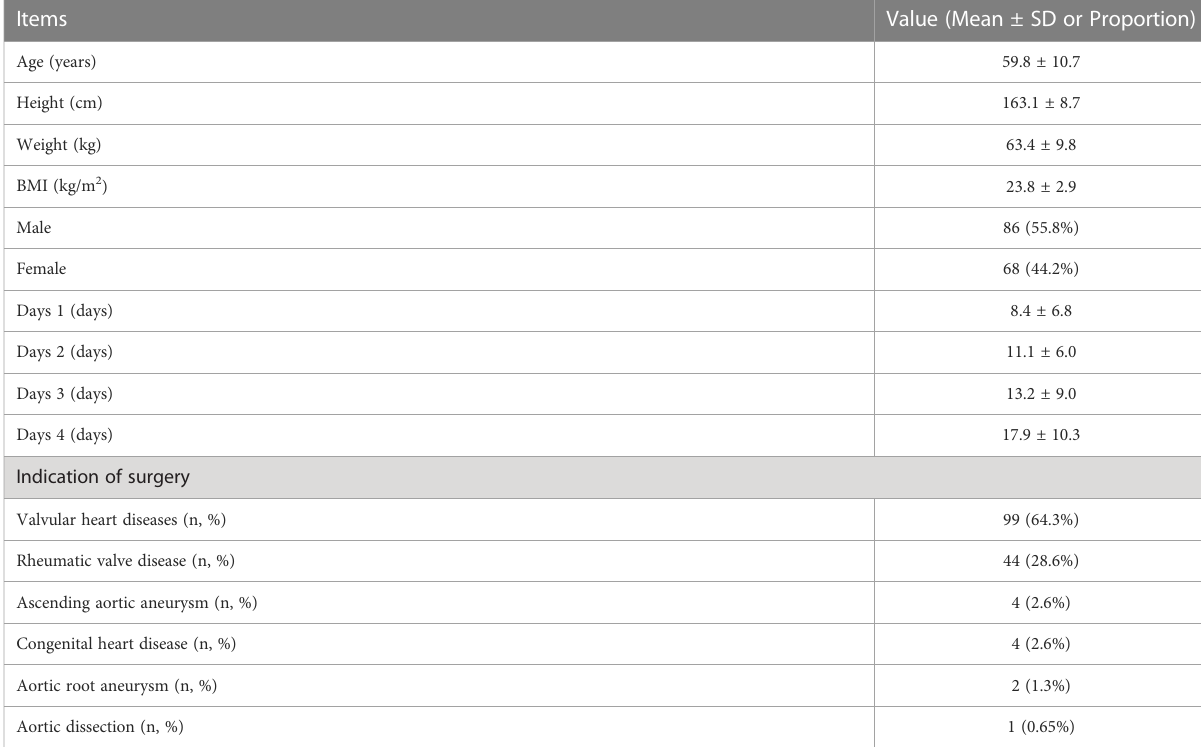
TABLE 1 Demographic characteristics of the patients.